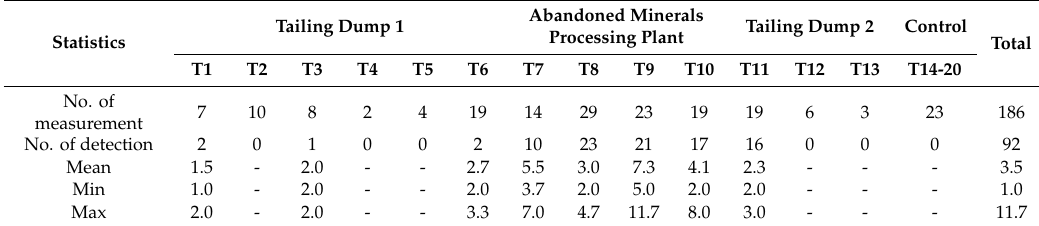
Table 2. Arsenic contents of pine needles sampled from study sites (mg /